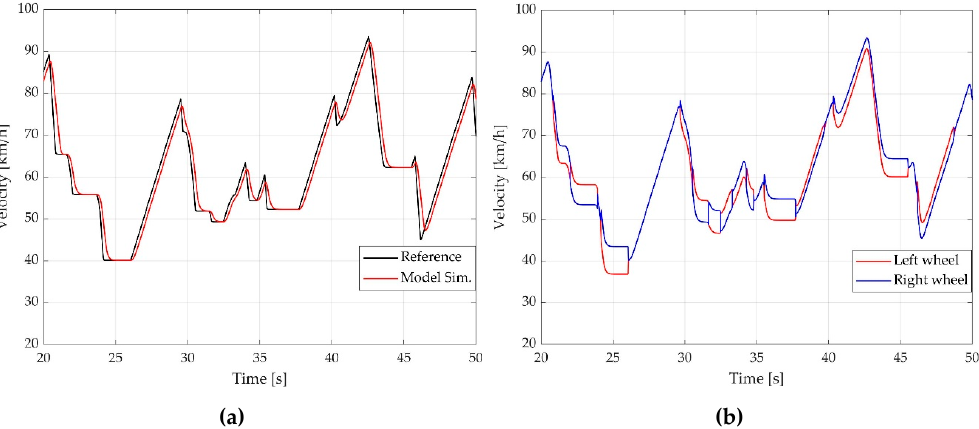
Figure 10. (a) Car velocity output; (b) Wheels velocity (electric differential effect).